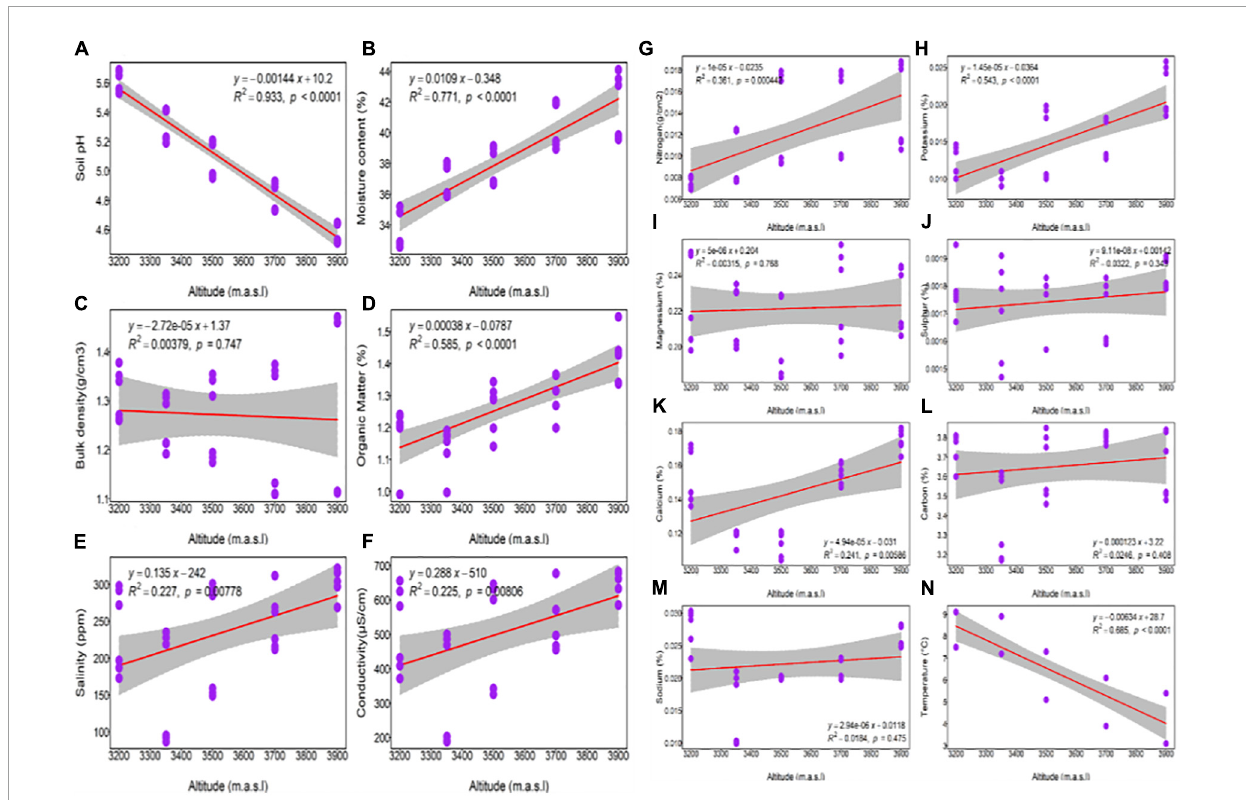
FIGURE2 Linear regression representing a change in soil physico-chemical parameters of Rhododendron anthopogon along the altitude gradient. Relationship between altitude and (A) soil pH; (B) moisture content; (C) bulk density; (D) organic matter; (E) salinity; (F) soil electrical conductivity; (G) nitrogen; (H) potassium; (I) magnesium; (J) sulfur; (K) calcium; (L) total soil organic carbon; (M) sodium; (N) soil temperature. Each purple dot in the plot represents the mean value of the soil physico-chemical parameters, and the gray areas represent a 95% confidence